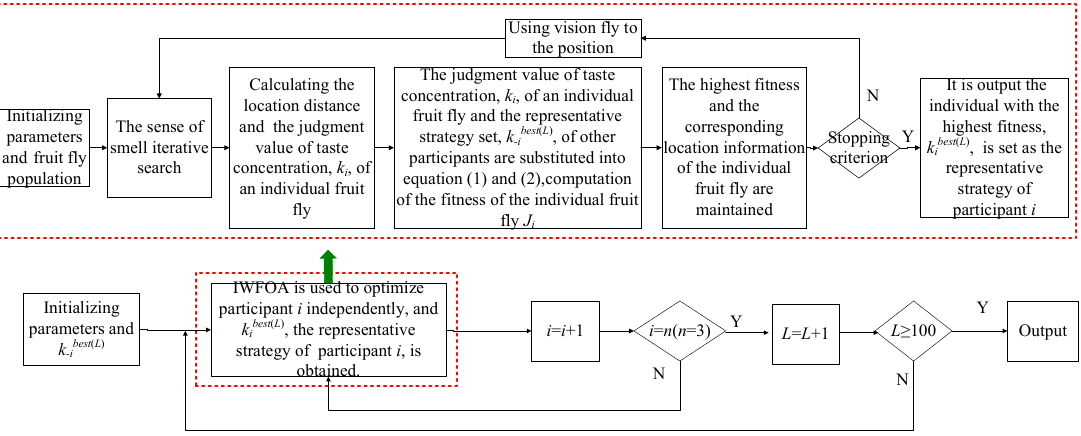
Table 1. Constrained